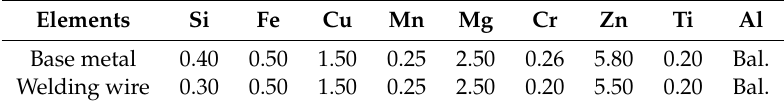
Table 1. Chemical compositions of the base metal and welding wire (mass,